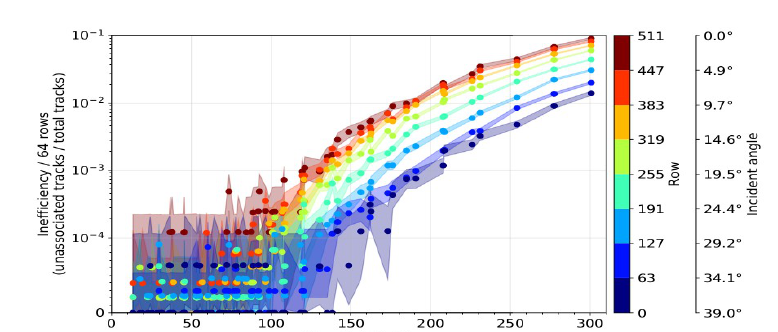
Fig. 4. Inefficiency as a function of threshold for different rows and incident angles. The dark circles represent the calculated efficiency and the shaded areas the statistical uncertainty. Each data point corresponds to at least 8k tracks.